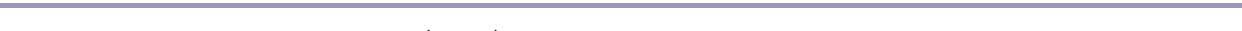
Table 4 . Torres Strait Regional Authority (TSRA) Community Fisher Group and/or islander representation in the Protected Zone Joint Authority (PZJA) consultative committees relative to the total number of representatives with a voting mandate on each, sorted according to the application of traditional ecological knowledge (TEK). Abbreviations are: Working Group (WG), Management Advisory Committee (MAC), Tropical Rock Lobster Resource Assessment Group (TRLRAG), Scientific Advisory Committee (SAC), and Turtle and Dugong Management Plan